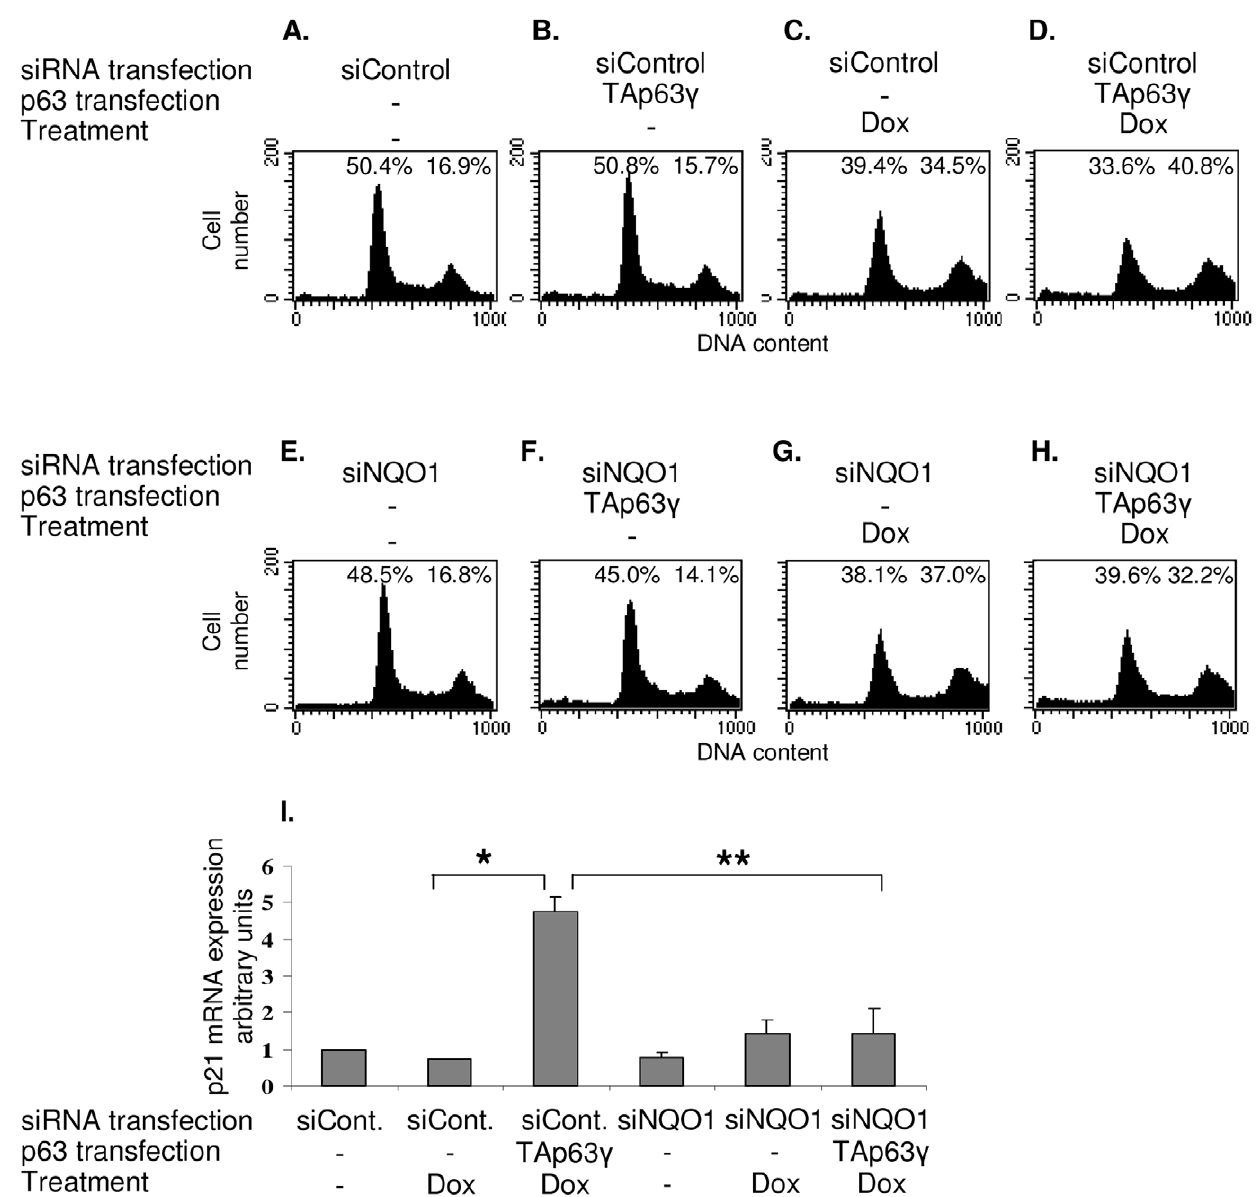
Figure 4. Downregulation of NQO1 inhibits TAp63 c -dependent growth arrest in DOX treated HCT116 2 / 2 cells. HCT116 2 / 2 cells were transfected with scrambled oligonucleotides (siControl) (A–D) or siNQO1 oligonucleotides (E–H) and transfected (B, D, F, H) or not (A, C, E, G) with a plasmid expressing TAp63 c . Twenty-four hours post-transfection the cells were treated or not with 0.05 m M DOX. 24h after this treatment, DNA content was analyzed by propidium-iodide staining. The percentage of cells in G1 and G2 is presented. (I) RNA was prepared from these same cells, reverse transcribed and real time PCR was performed using primers specific for p21 and 18S rRNA. Data is represented as relative levels of p21 normalized to 18S rRNA. *p , 0.05, **p ,